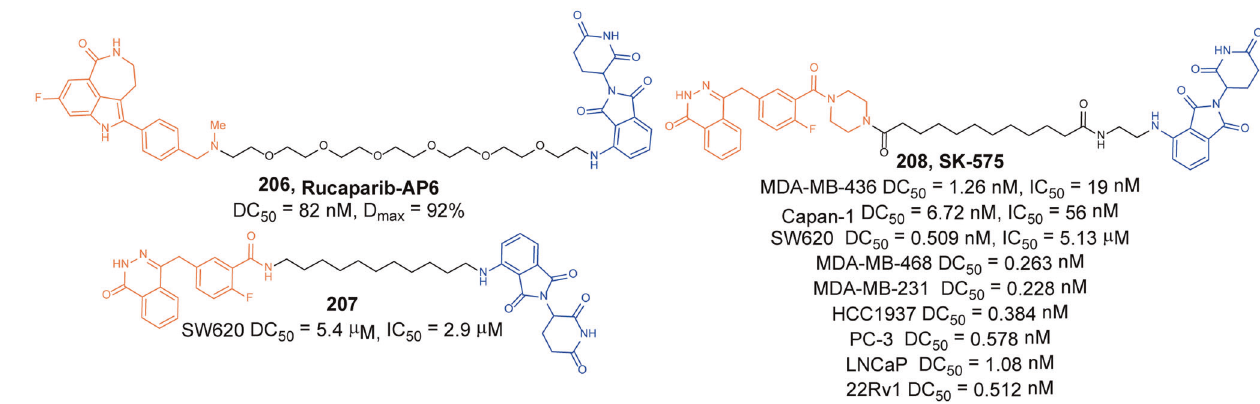
Fig. 61 The representative PROTACs targeting PARP1